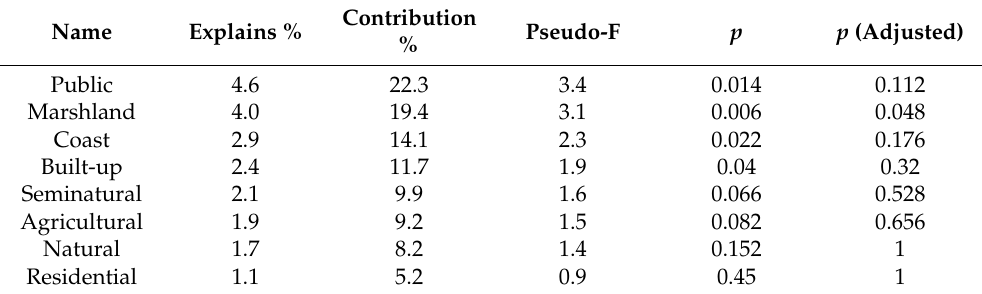
Table 3. Forward selection results of the CCA analysis. Total variation is 4.66, explanatory variables account for 20.7% (adjusted explained variation is 10.8%).